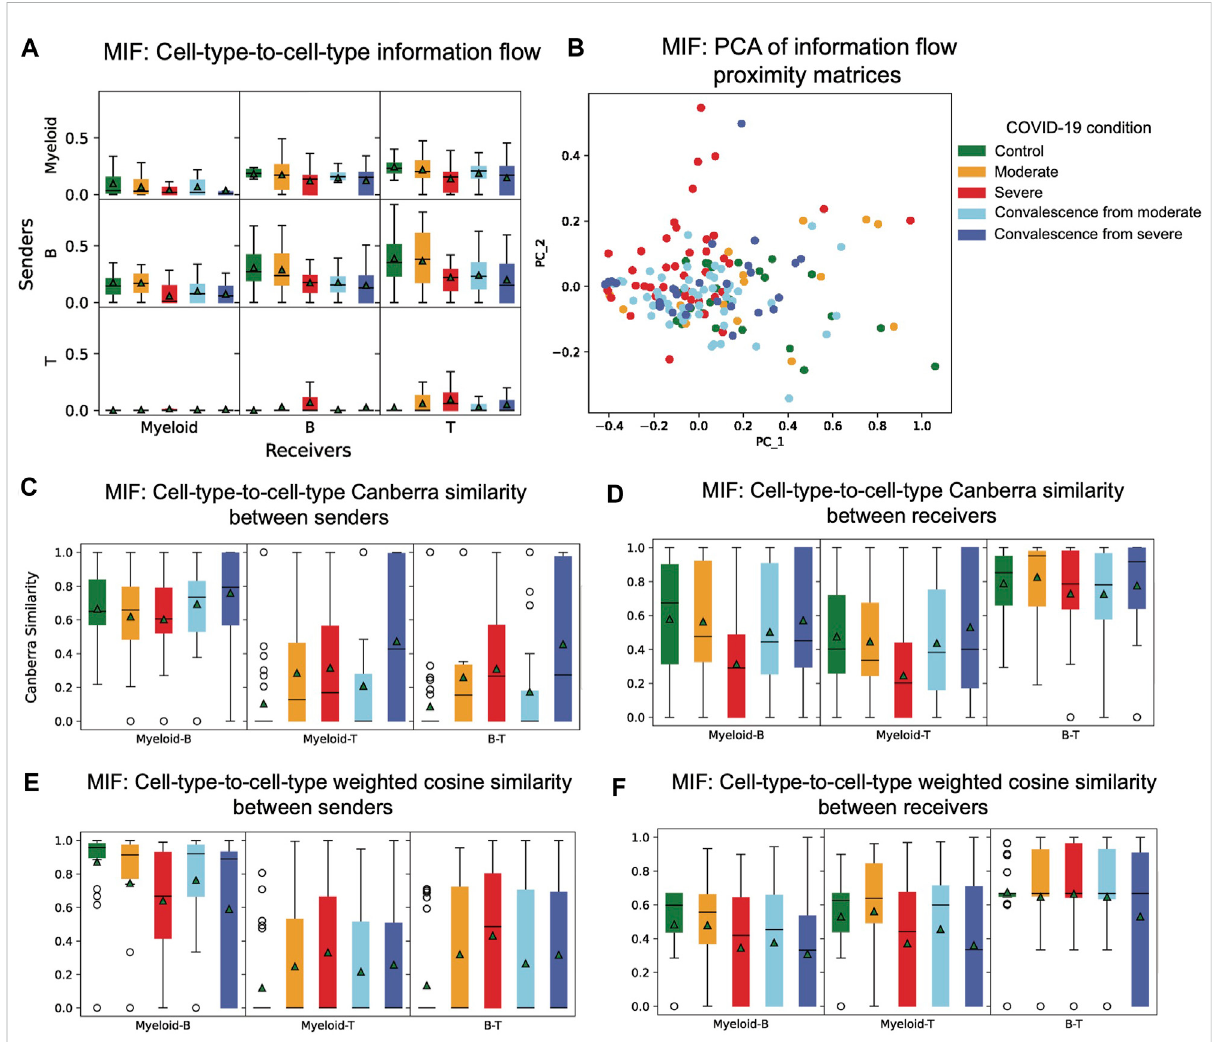
FIGURE 4 Distribution of cell-type-to-cell-type features. (A) Distribution of information fl ow between cell types of fi ve COVID-19 conditions in the MIF pathway.WhenBcellsarethesendercelltypeineachgroupofcondition,meanandvarianceofinformation fl owincreasesfrommyeloidtoBcellsto T cells as receiver cell types. (B) PCA of information fl ow proximity matrices of fi ve COVID-19 conditions in the MIF pathway. There is a clear pattern that differentiates severe patients from healthy controls and moderate patients. (C) Distribution of cell-type-to-cell-type modi fi ed